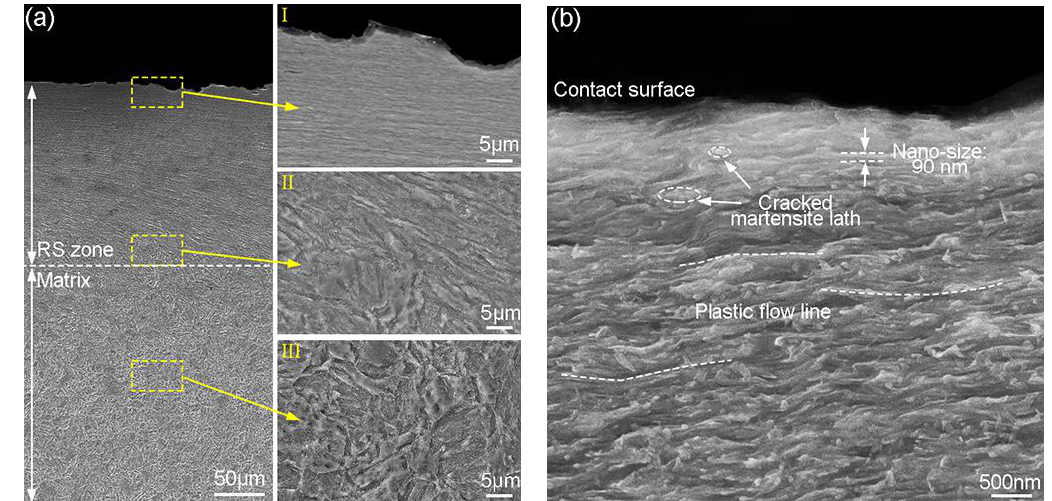
Figure 8. FESEM image of ( a ) martensite lath characteristics, and ( b ) the topmost surface microstructure of the RS zone.